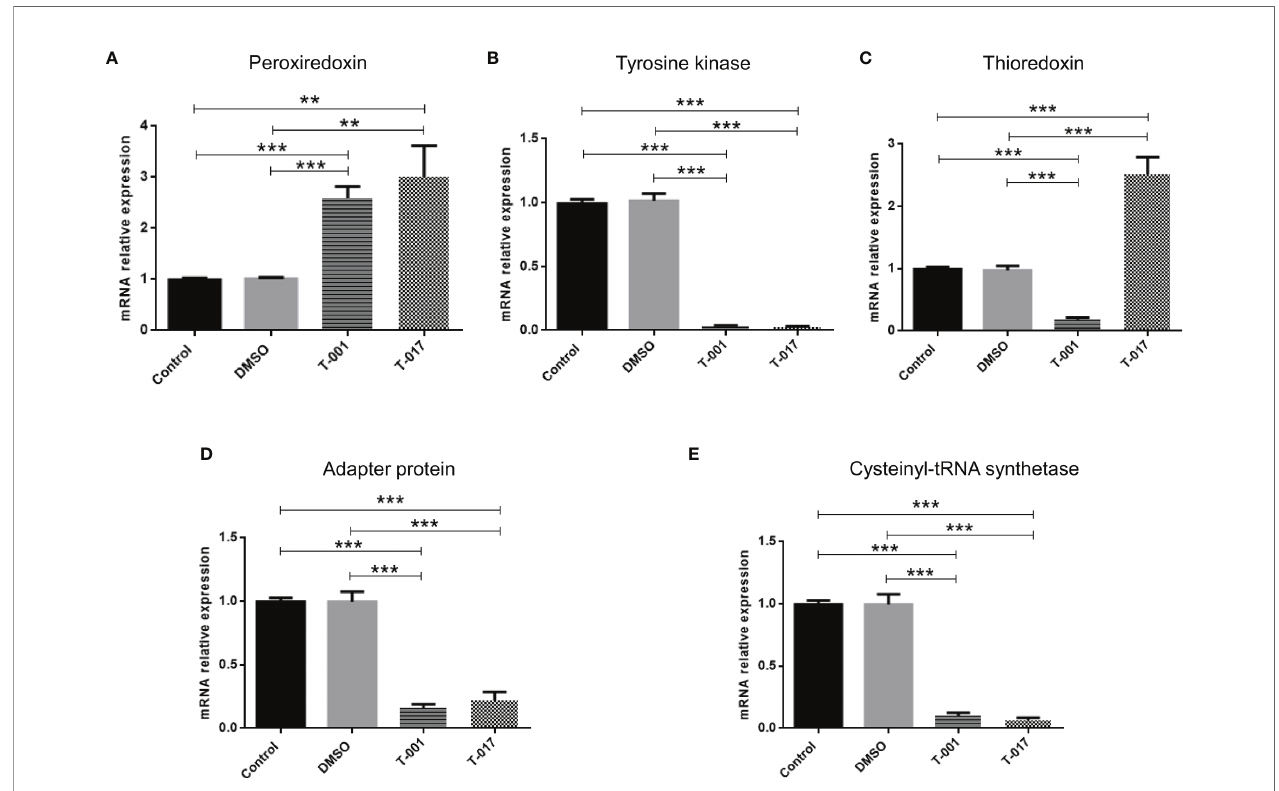
FIGURE 2 | mRNA expression in E. histolytica trophozoites under the effect of T-001 or T-017. Trophozoites were treated with T-001 or T-017 during 48 h. Total RNAs were obtained and qRT-PCR was performed using Sensi FAST SYBR Hi-ROX master mix (Bioline), and speci fi c primers to amplifying (A) Peroxiredoxin, (B) Tyrosine kinase, (C) Thioredoxin, (D) Adapter protein and (E) Cysteinyl-tRNA synthetase, as well as RNA Pol lI as endogenous control gene. Relative fold increase in gene expression was obtained using the DD CT method. Data corresponds to mean ± SD, of three independent experiments. Statistically signi fi cant differences in mRNA expression were analyzed using a Tukey test method with Sigma Stat statistical software ver.2.0. p ≤ 0.01 (**), p ≤ 0.001